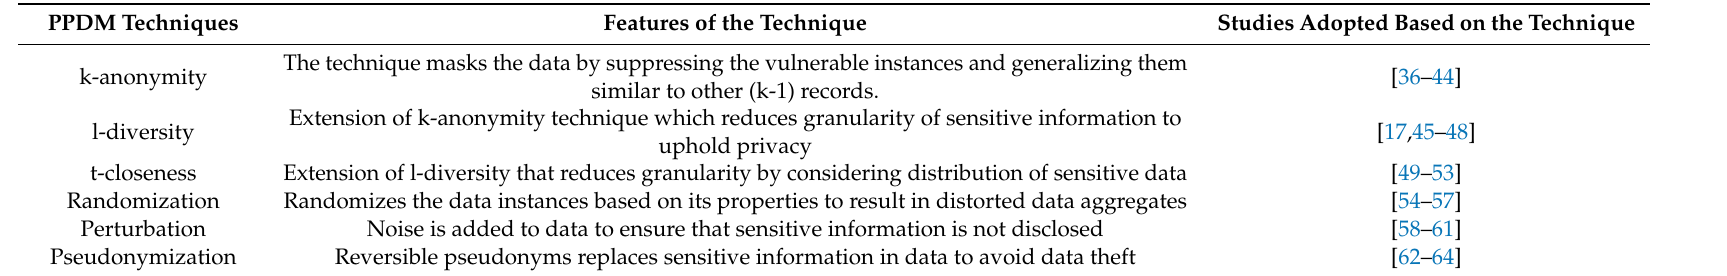
Table 2. Significance of PPDM approaches towards data